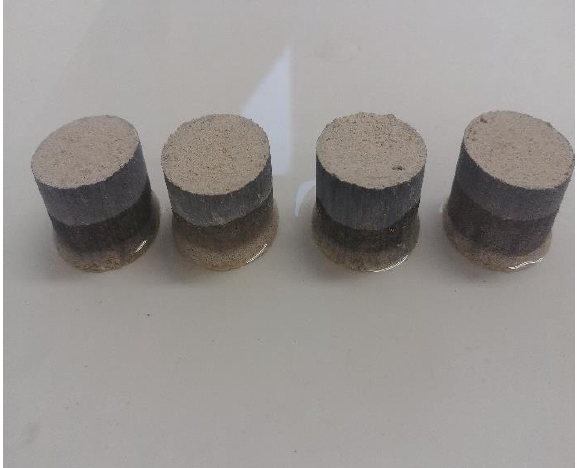
Figure 4: Extract from scheme for heating samples during autoclav- ing.